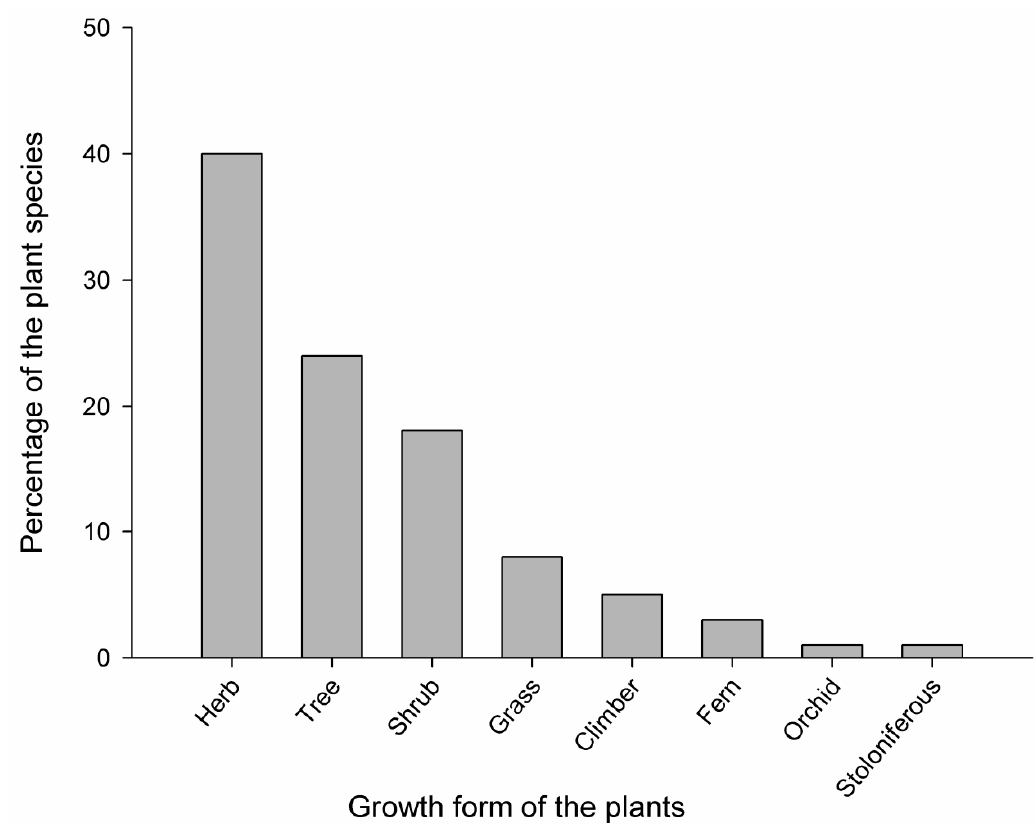
Figure 2. Growth form of the plant species used by the local people.